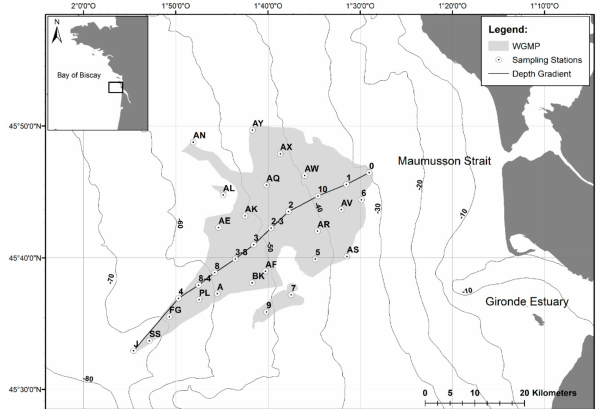
Figure 1. Map showing the location of the West Gironde Mud Patch along the French Atlantic coast, the locations of the 32 sampled stations, and the depth gradient sampled for X-ray radiographies and amino acids. The delimitation of the West Gironde Mud Patch (WGMP) is based on the acous- tic measurements achieved during the JERICOBENT-5-TH cruise [48] and the surface sediment granulometry assessed during the present study